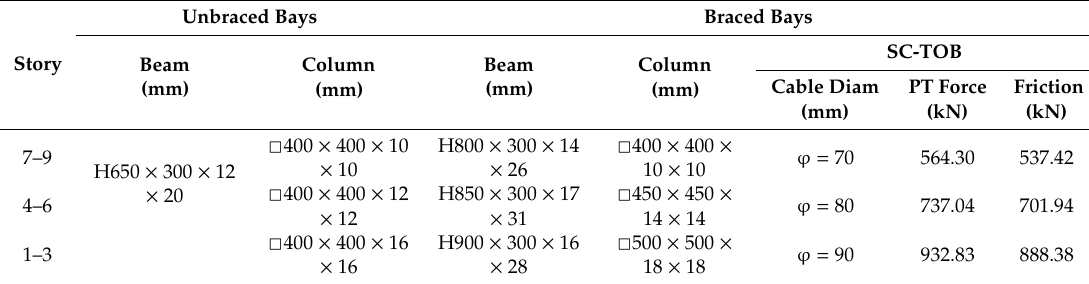
Table 1. Detailed properties of structural elements in the prototype building.